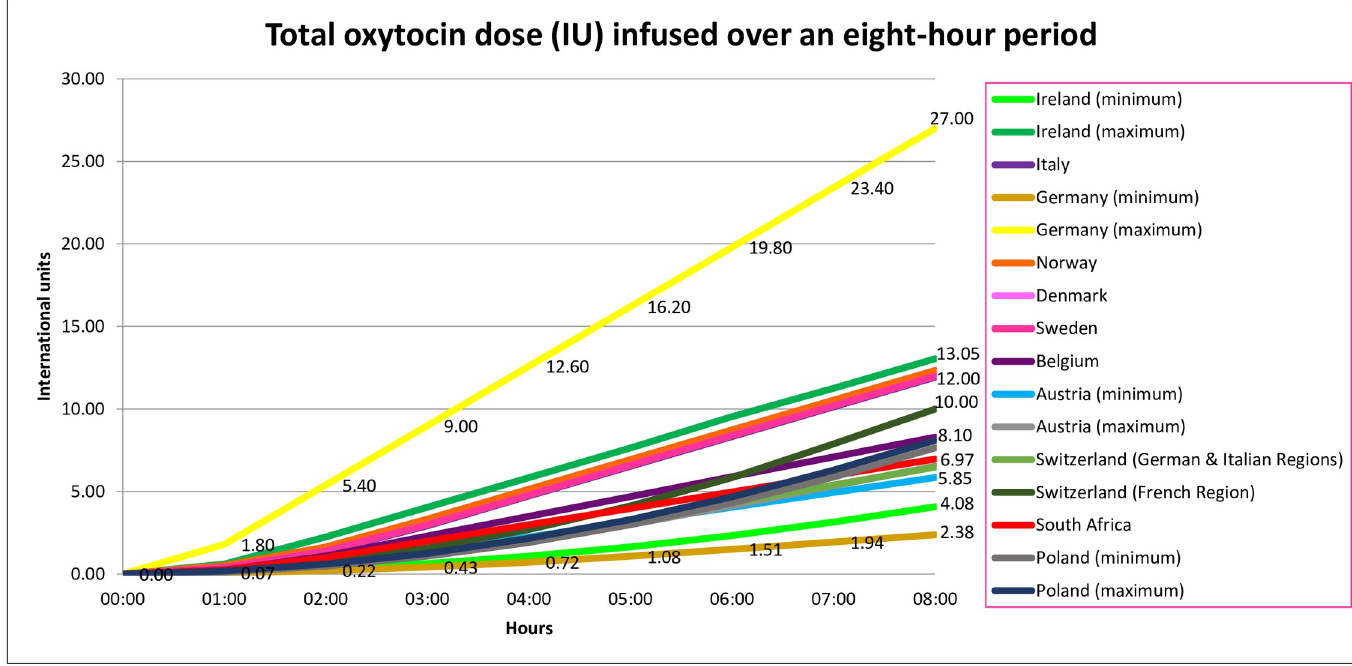
Fig 2. Total oxytocin dose (IU) infused over an eight-hour